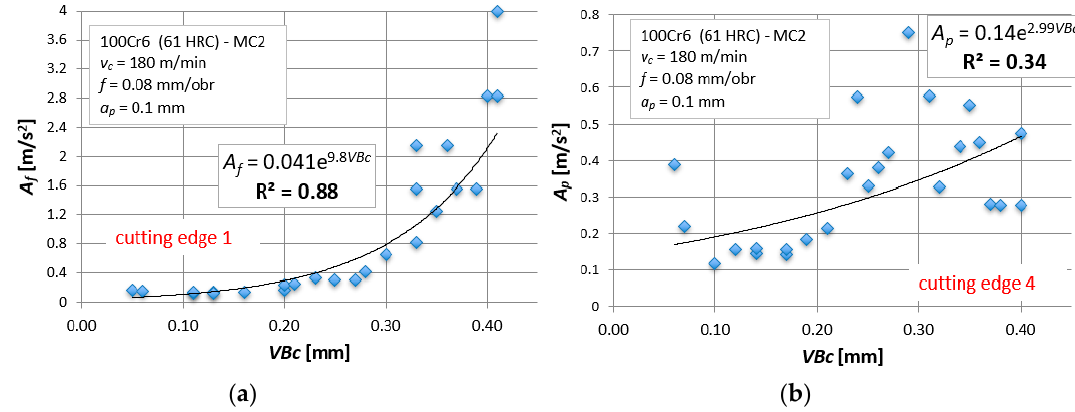
Figure 7. Acceleration of vibrations in feed direction, Af, as a function of the tool wear, VBc, for tool tips ( a ) No. 1 and ( b ) No. 4.